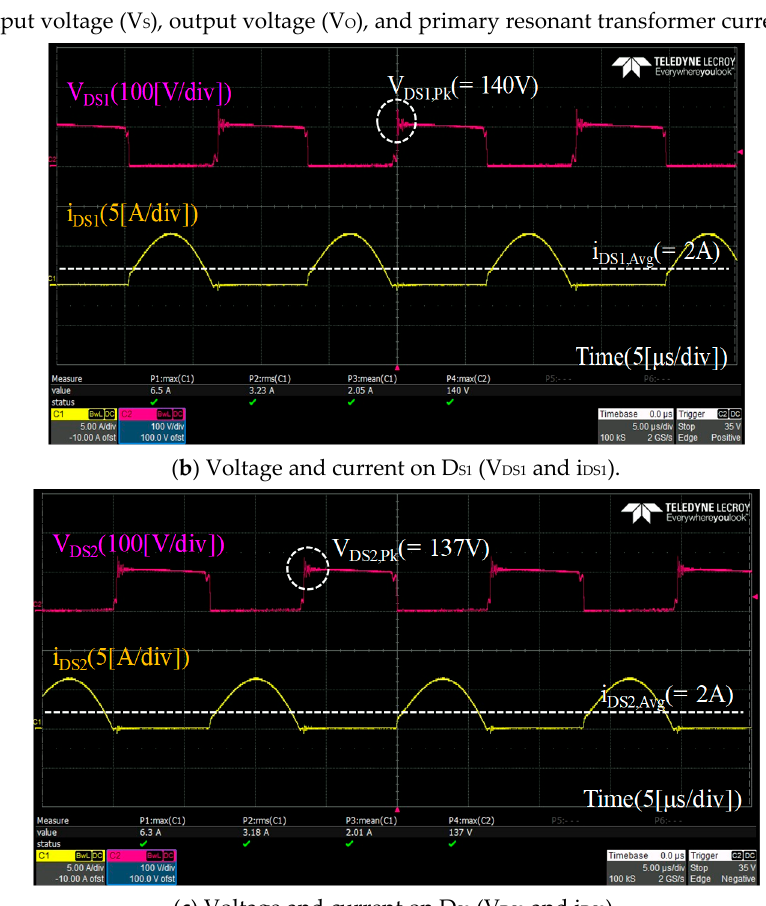
Figure 7. Experimental waveforms with a realized H/W in proposed quadrupler.